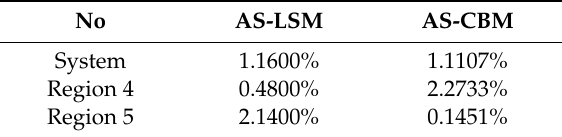
Table 3. The absolute error of probabilities for the system, region 4, and region 5 RoCoF by AS-LSM and AS-CBM within operational limits (uncorrelated wind speed).